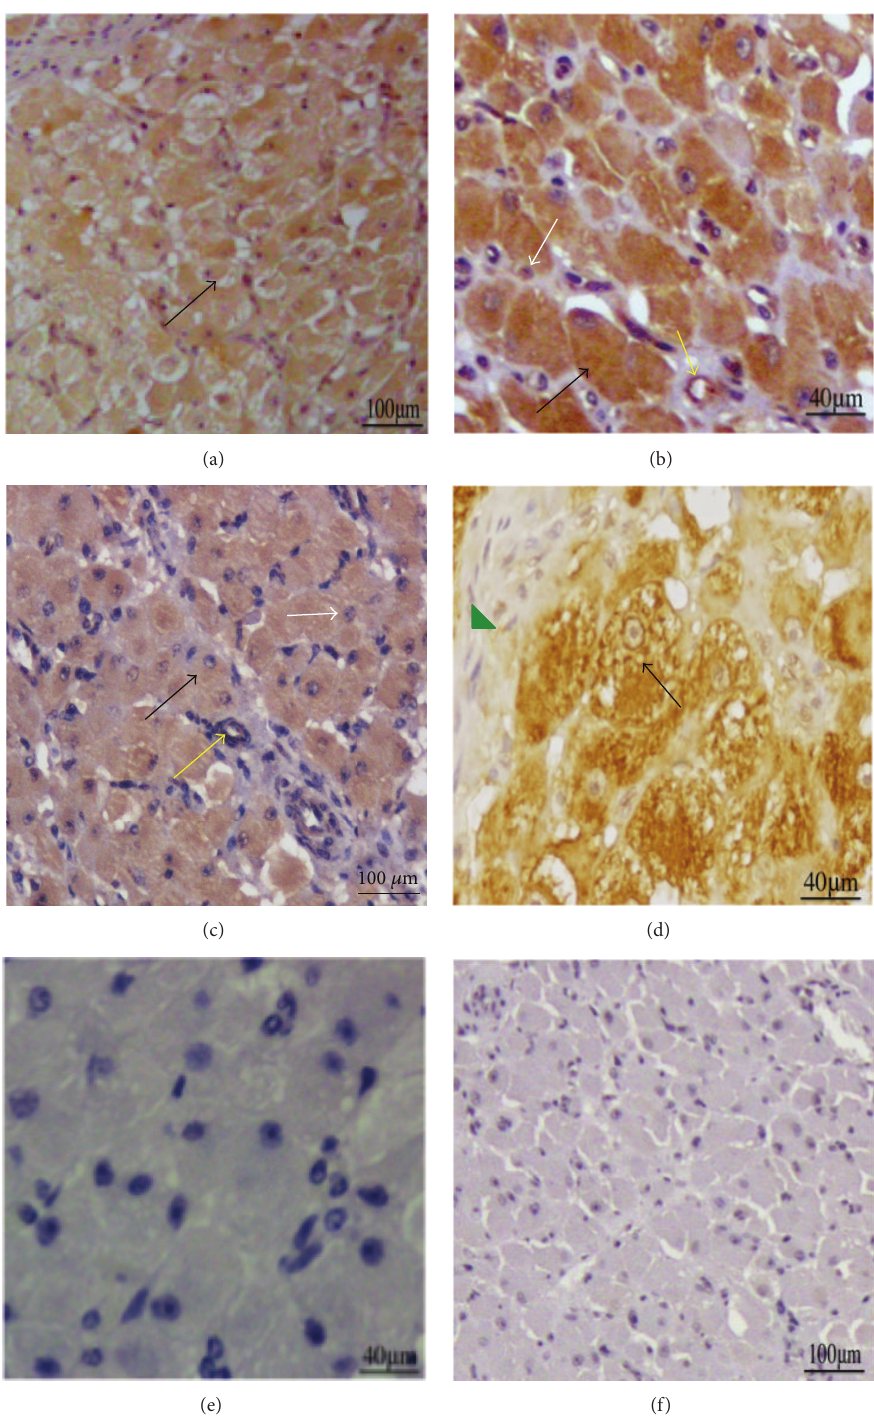
Figure 1: Representative images of equine CL immunostained for the presence of LEP in early CL (a), LEPR in mid-CL (b), GHR in mid-CL (c), Ghr-R1A in late CL ((d) characteristic increased number of vacuole in LLC and connective tissue for late CL-green triangle). Negative control with substitution of primary antibody by rabbit IgG (e) and by PBS (f). Black arrow indicates LLC, white arrow indicates SLC, and yellow arrow indicates endothelial cells. Since all cytokines/receptors stained equally throughout the estrous cycle, pictures from each luteal phase were randomly